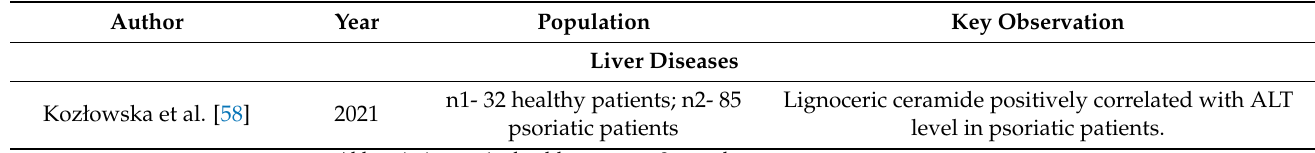
Table 6. Summary of the studies on sphingolipid metabolism in psoriasis and liver disease.